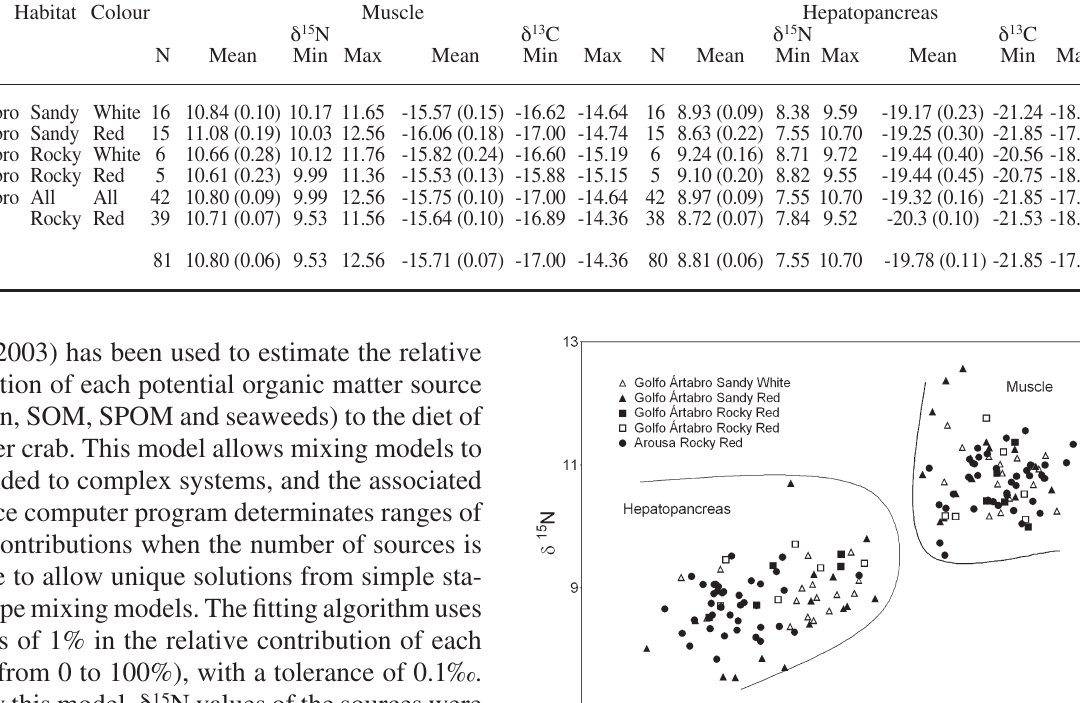
Table 3. – average (Se in parentheses) and minimum and maximum values for δ 15 n and δ 13 C in hepatopancreas and muscle of spider crabs Maja brachydactyla from the ria de arousa and Golfo ártabro, in relation to habitat (substrate) and body colour. n=number of individuals. area